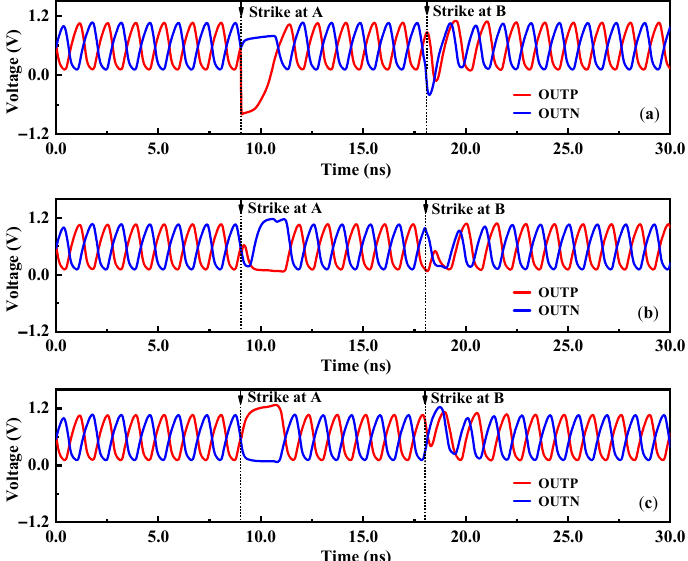
Figure 3. Simulation results of the SET responses of different nodes and different delay units in the VCO: ( a ) bombardment of CELL1; ( b ) bombardment of CELL2; and ( c ) bombardment of CELL3.